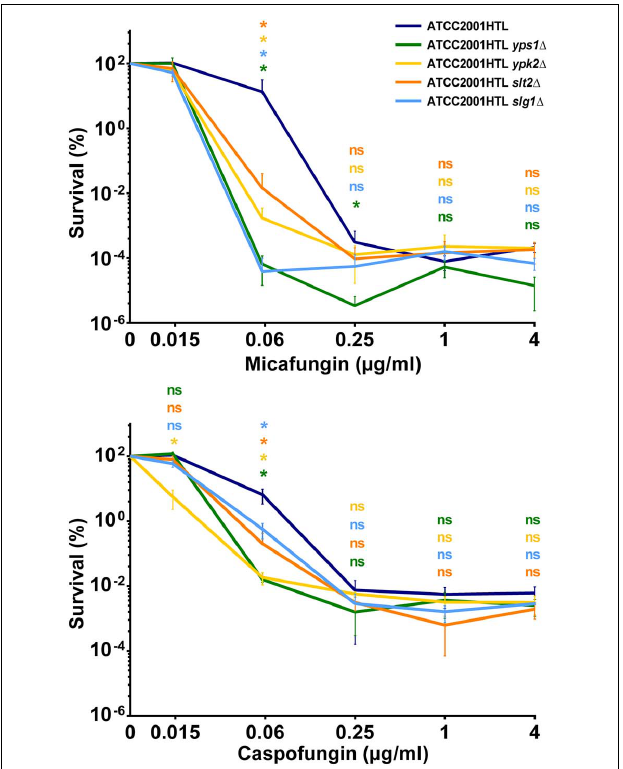
FIGURE 1 | Deletions of genes involved in cell wall maintenance exhibited significantly reduced tolerance to micafungin and caspofungin. Survival percentage was obtained by normalizing the colony forming units (CFU) obtained from cultures treated with the indicated drug concentrations normalized to non-treated controls for each strain. A decrease in drug tolerance was observed in one or more drug concentrations of micafungin or caspofungin in yps1 (cid:49) , ypk2 (cid:49) , slt2 (cid:49) , and slg1 (cid:49) mutants after 24 h-drug exposure to a wide range of concentrations. Results were calculated from at least three independent biological replicates. The statistical significance was calculated using an unpaired t -test and is indicated with an asterisk (*) or with n.s. (not